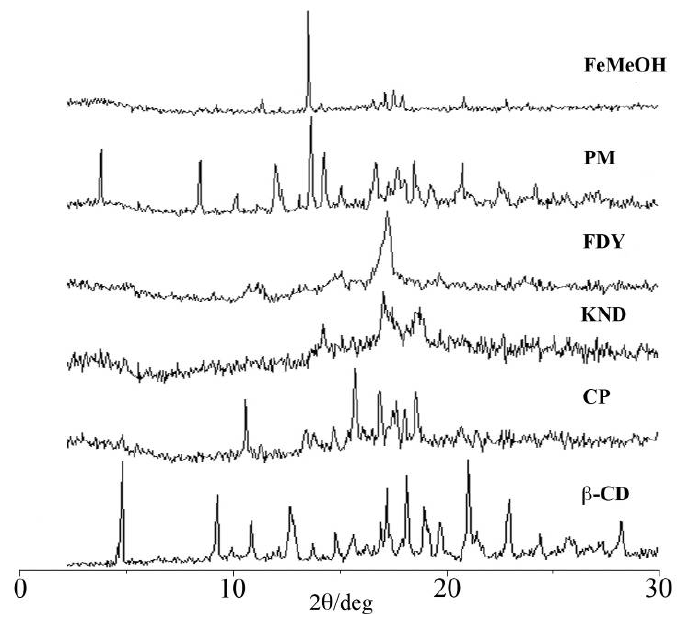
Figure 2. The powder XRD patterns of β -CD, CP, KND, FDY, PM and